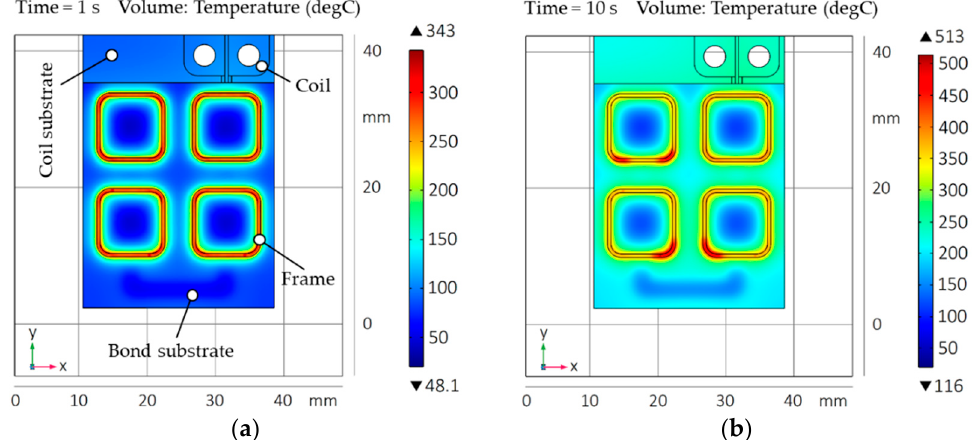
Figure 16. FE simulation for designing the micro coil geometry: ( a ) Bond frame and substrate temperature after t h = 1 s; ( b ) Bond frame and substrate temperature after t h = 10 s.